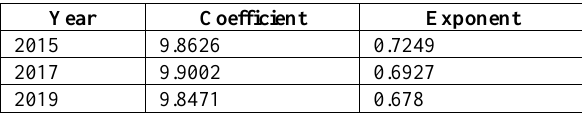
Table 2. Coefficients and exponents of the allometric formulas